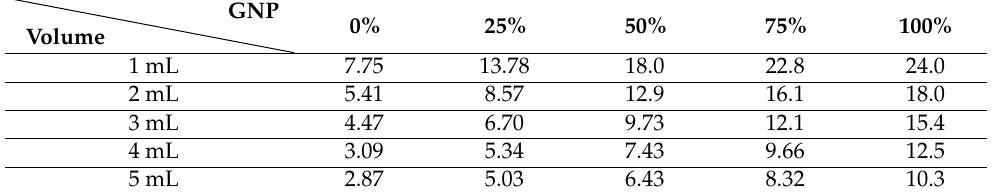
Figure 9. Gauge factor of hybrid nanomaterial film varying with spray volumes and GNP contents. Figure 10. Conductive networks change of the hybrid nanomaterial film under stretching.